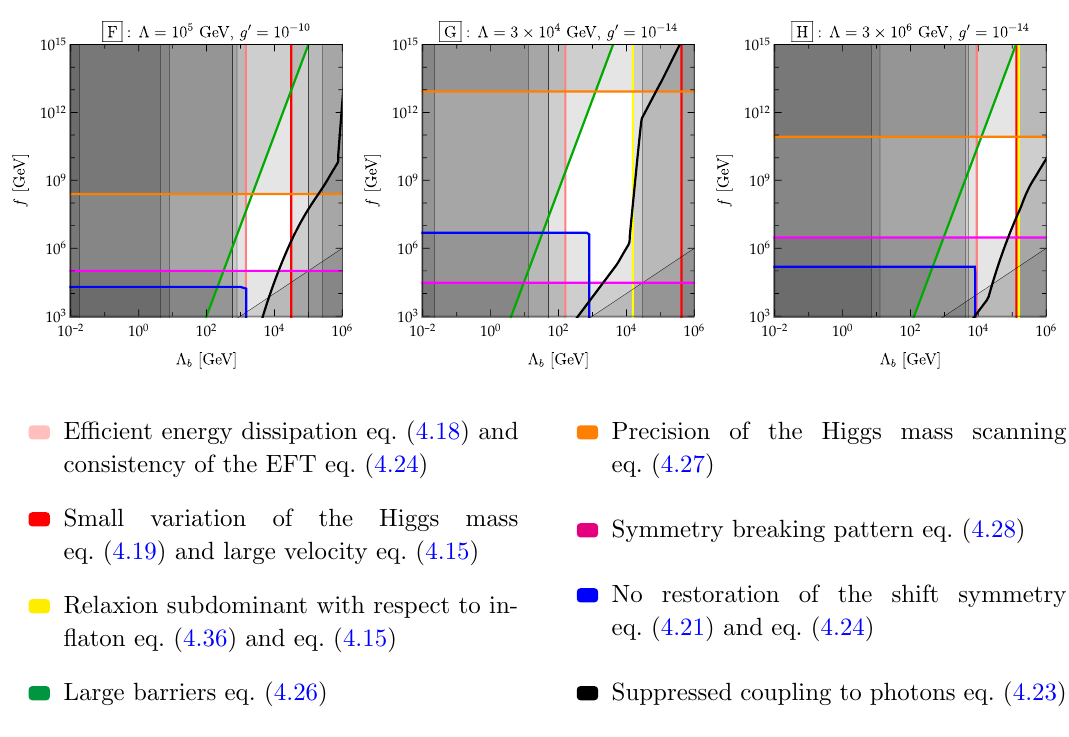
(cid:13)aton eq. (4.36) and eq. (4.33)